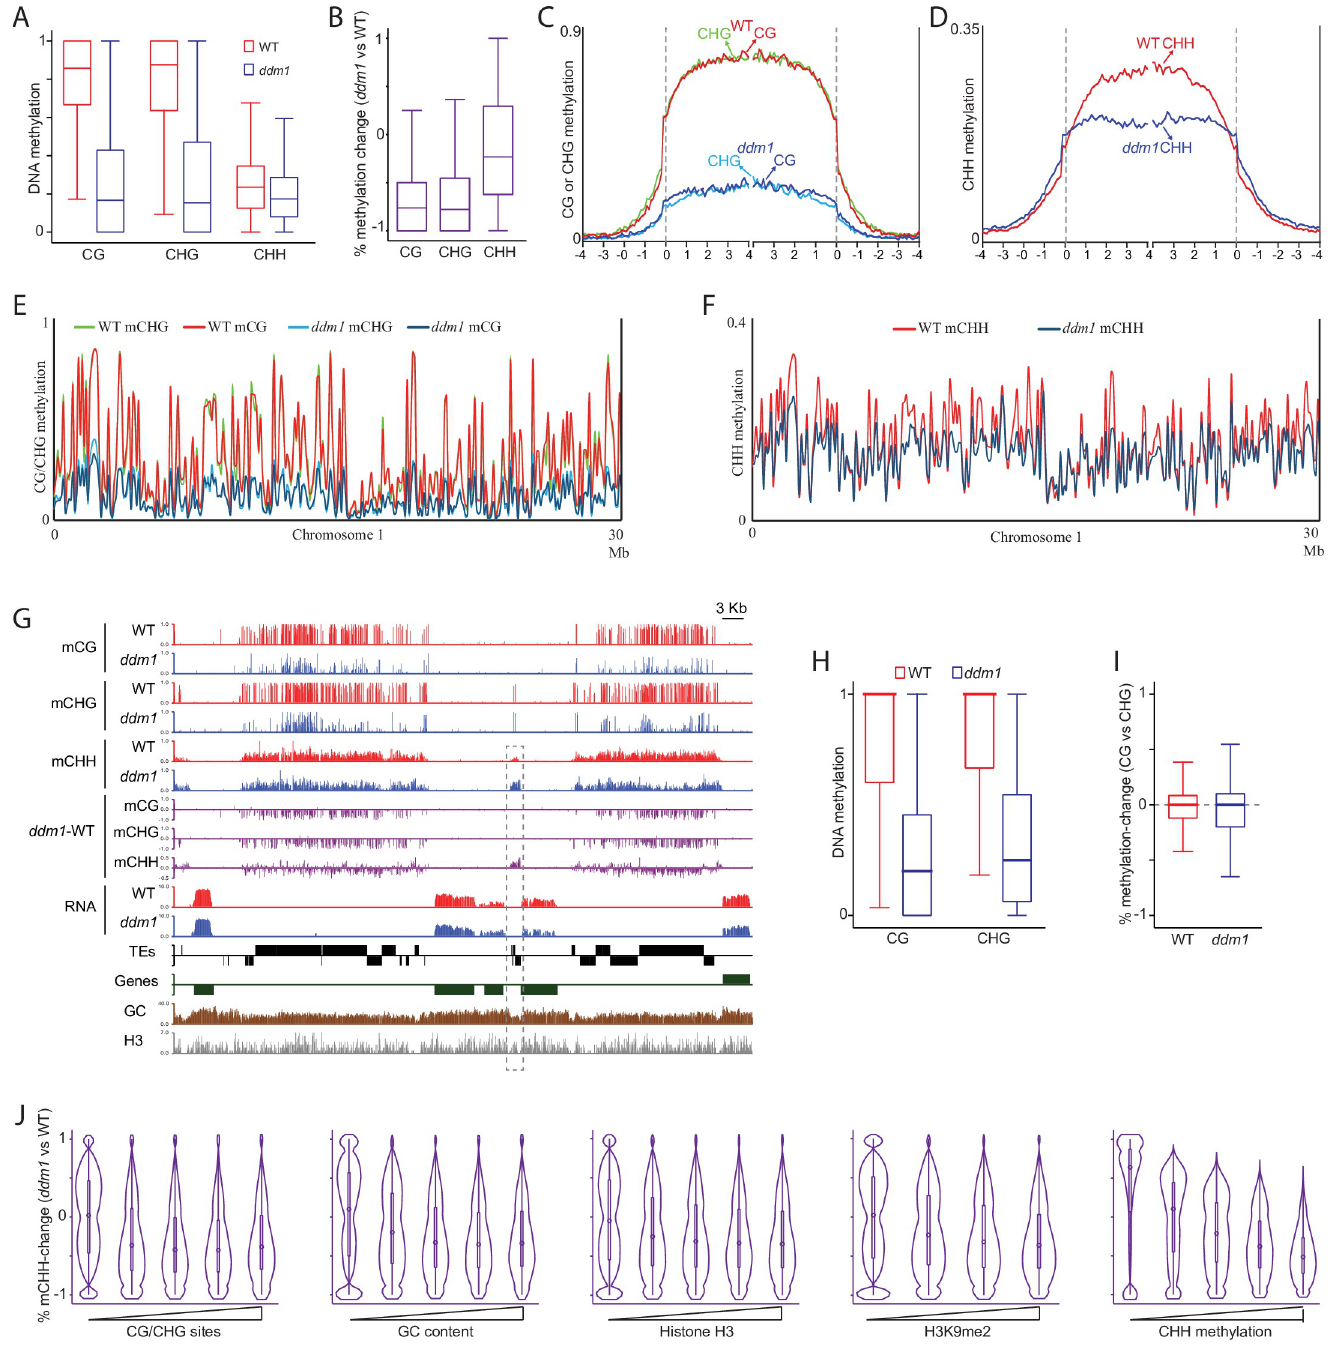
Fig 2. DNA methylation in Ppddm1 . A. Box plots of DNA methylation (separated to CG, CHG, and CHH contexts) in wild type and Ppddm1 in TEs. B. Box plots of percent methylation change in TEs between Ppddm1 versus wild type calculated for 50-bp windows. C-D. Patterns of CG and CHG methylation (C) and CHH methylation (D) in wild type and Ppddm1 across TEs. TEs were aligned at the 5 0 or 3 0 ends, and methylation was averaged within 50-bp intervals. The dashed lines represent points of alignment. E-F. Average of CG and CHG methylation (E) and of CHH methylation (F) in wild type and Ppddm1 along P . patens chromosome 1 averaged in a 100-kb sliding window. G. A genomic representative snapshot of hypo-methylated TEs and a hyper-methylated TE (marked in dotted line) in Ppddm1 . DNA methylation, methylation difference ( Ppddm1 minus wild type), RNA level, GC content, and histone H3 are plotted in 50-bp windows. Genes and TEs oriented 5’ to 3’ and 3’ to 5’ are shown above and below the line, respectively. H. Box plots of CG and CHG methylation in wild type and Ppddm1 within methylated 50-bp windows ( > 0.5 methylation in either of the samples) and with an equal number of CG and CHG sites. I. Percent-methylation change between mCG and mCHG in wild type and Ppddm1 (i.e. WT-mCG minus WT-mCHG (red) and ddm1 -mCG minus ddm1 -mCHG (blue)), within windows with an equal number of CG and CHG sites. J. Violin plots of percent-methylation-change in 50-bp windows of CHH methylation in TEs between Ppddm1 and wild type, separated based on the level (quantiles) of indicated attributes. Histone H3 and H3K9me2 data were derived from Widiez et al ., [29].